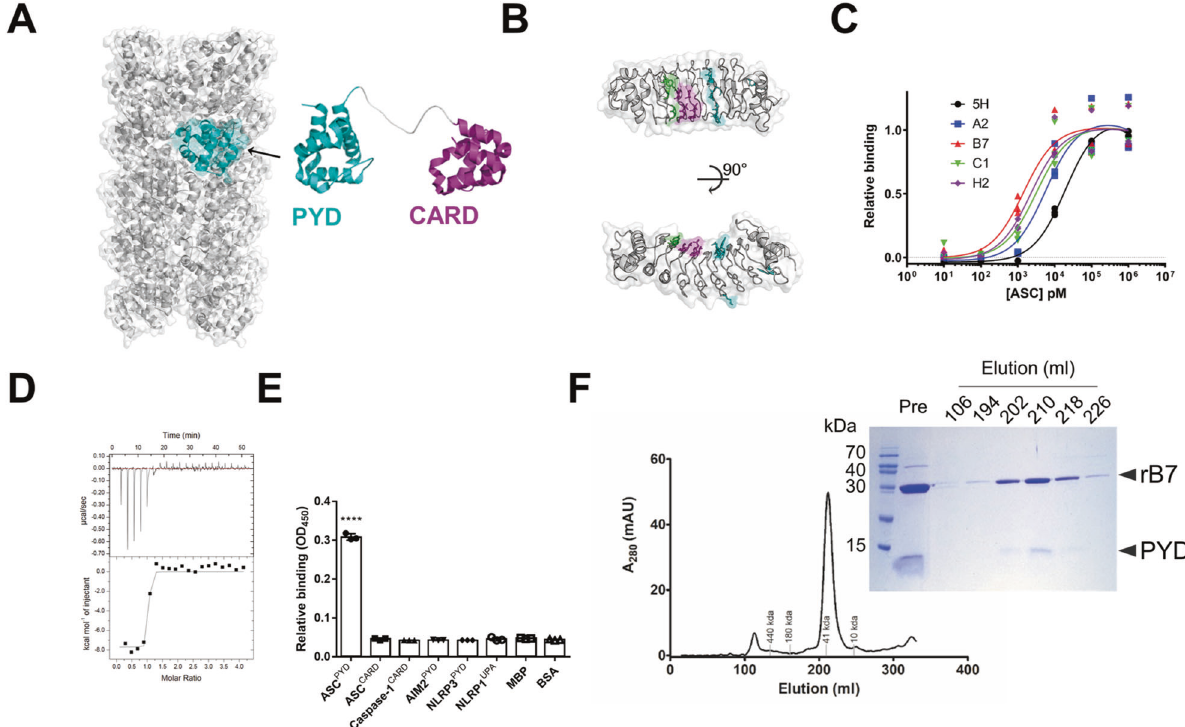
Fig. 1 Development and characterization of an ASC PYD -speci fi c protein binder. A Structure of ASC comprising PYD and CARD (PDB ID: 2KN6, 3J63). ASCs are oligomerized through homotypic interaction between PYDs. The surface model with gray color represents oligomerized ASC PYD molecules. B Structural representation of the repebody scaffold (PDB ID: 3RFS) used for the development of an ASC PYD -speci fi c protein binder. A repebody library was constructed by randomizing variable sites on LRR modules on a concave surface, followed by phage display selection against ASC PYD . Mutation sites for library construction are shown in color: fi rst library sites in purple, second library sites in green, and additional mutation sites in cyan. C Relative binding af fi nities of an initially selected repebody (r5H) and af fi nity-matured repebodies against ASC PYD using ELISA. The highest binding intensity was observed by rB7. The data represent the means ± SDs from triplicate experiments. D Titration curve of rB7 against ASC PYD using ITC. The binding af fi nity (K D ) of rB7 for ASC PYD was determined to be 1.5 nM. Data were representative of three independent experiments. E Speci fi city of rB7. The binding of myc-tagged rB7 (4 μ M) was tested against various proteins (50 nM) coated on immunoplate. BSA was used as a negative control. Relative binding was quanti fi ed by ELISA using myc-tag antibody. The data represent the means ± SDs from triplicate experiments. **** p < 0.0001 compared with the control (two-tailed unpaired Student ’ s t- test). F Elution pro fi le of rB7 in complex with ASC PYD on size-exclusion chromatography. Inset represents SDS/PAGE analysis for eluted fractions from size-exclusion